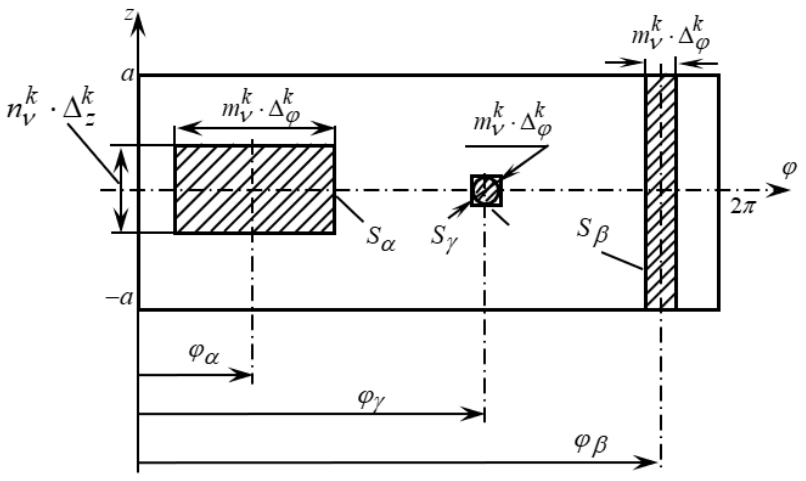
Figure 1. The scan of the lubricating film in the presence of lubrication sources of various shapes on the friction surface.